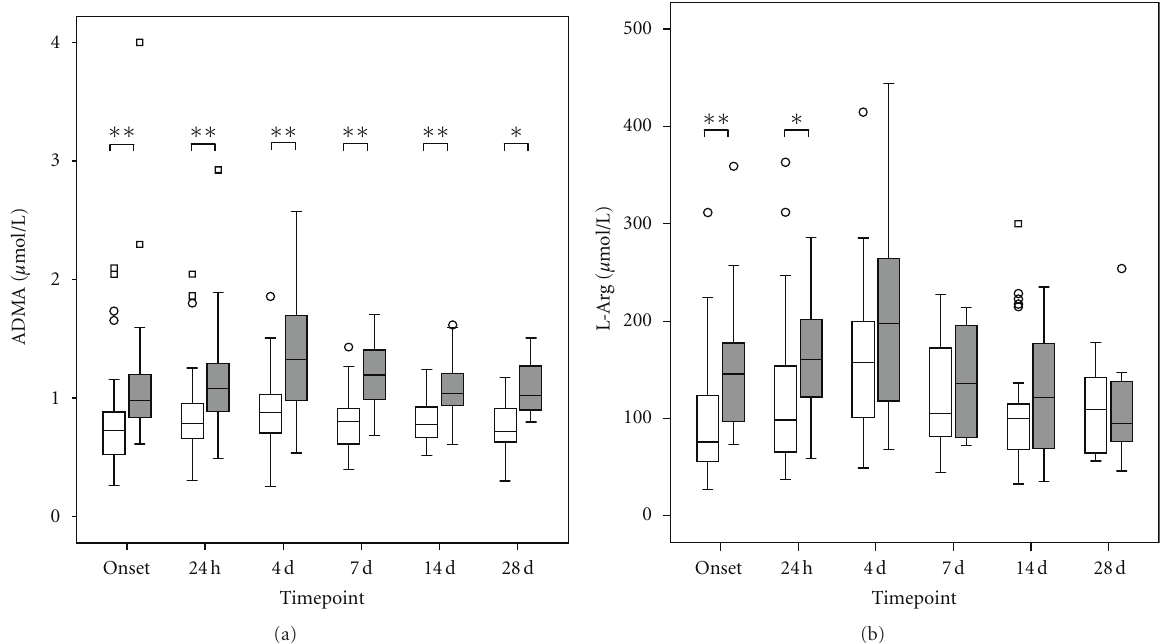
Figure 2: Comparison of ADMA (a) and L-arg (b) measurements in plasma samples of septic patients with an ALF ( n = 15, grey box) in comparison to septic patients with a preserved liver function ( n = 45, white box). Data in box plots are given as median, 25th percentile, 75th percentile, and the 1.5 interquartile range. Outliers are shown in form of circles (1.5–3 interquartile ranges above 75th percentile or below 25th percentile) or rectangles ( > 3 interquartile ranges above 75th percentile or below 25th percentile). Concerning symbolism and higher orders of significance: P < 0 . 05: ∗ , P < 0 . 01: ∗∗ , P < 0 . 001: ∗∗∗ , n.s.: not statistically